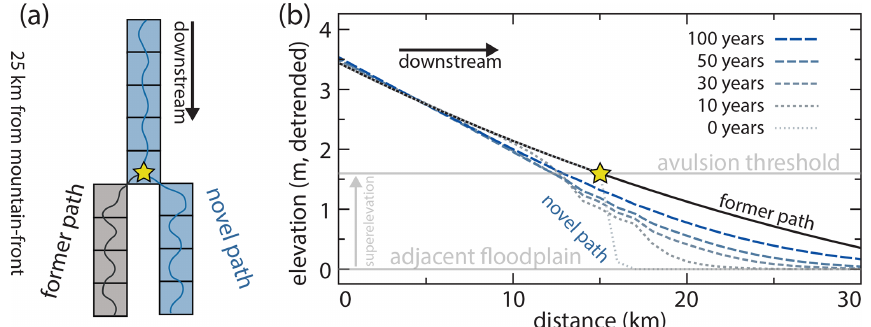
Figure 8. Model example showing channel evolution immediately after an avulsion at a node marked by a star. (a) Planform arrangement of the parent channel and avulsion node, with both pathways of equal length. (b) Detrended elevation of the parent channel (relative to the adjacent floodplain) and new avulsion pathway upstream and downstream of the avulsion node. Immediately prior to the avulsion (black line), all cells upstream of the avulsion node are superelevated and are equally likely to avulse if a trigger occurs. After the avulsion, gradual knickpoint propagation upstream reduces superelevation. Downstream of the avulsion site, there is significant deposition that reduces the time to